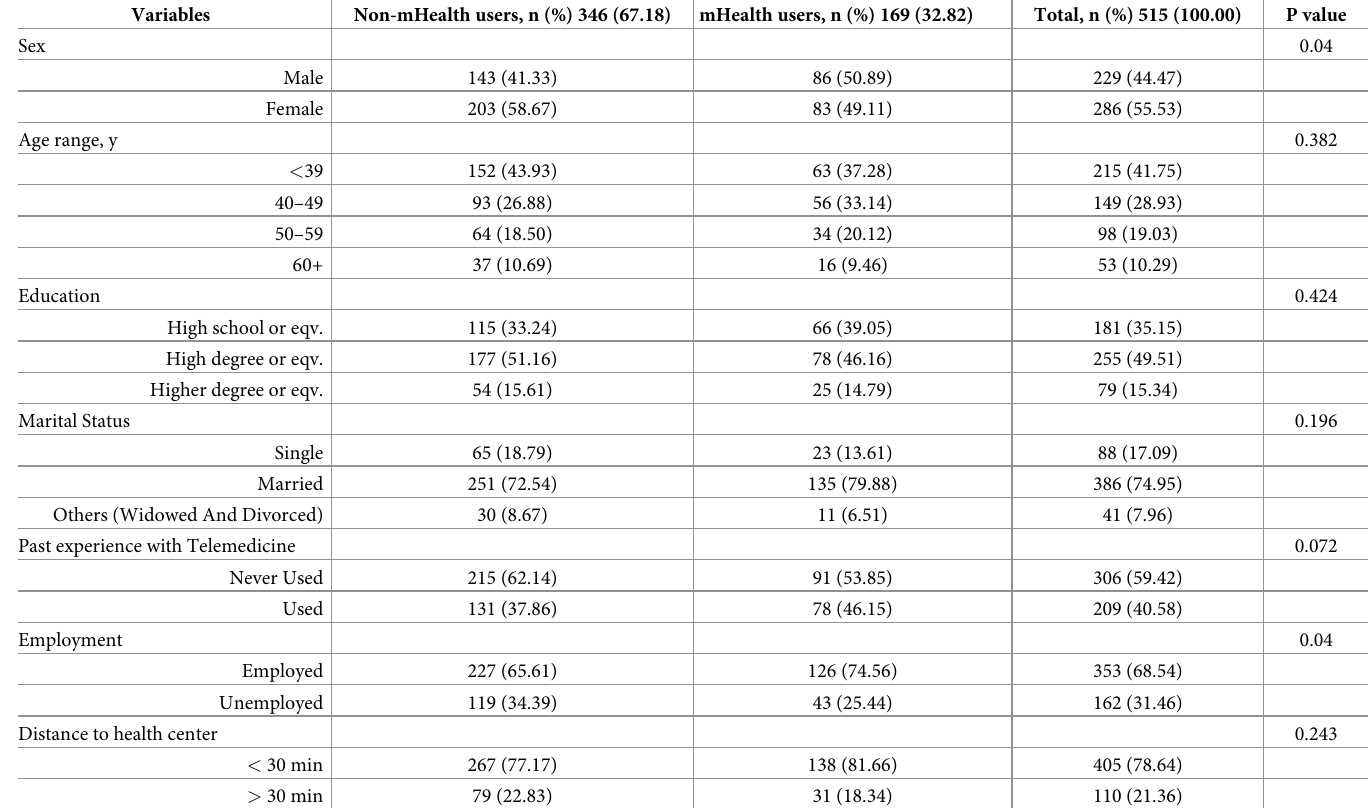
Table 1. Patient socio-demographic characteristics and descriptive statistics by “Remote Care” application user type.